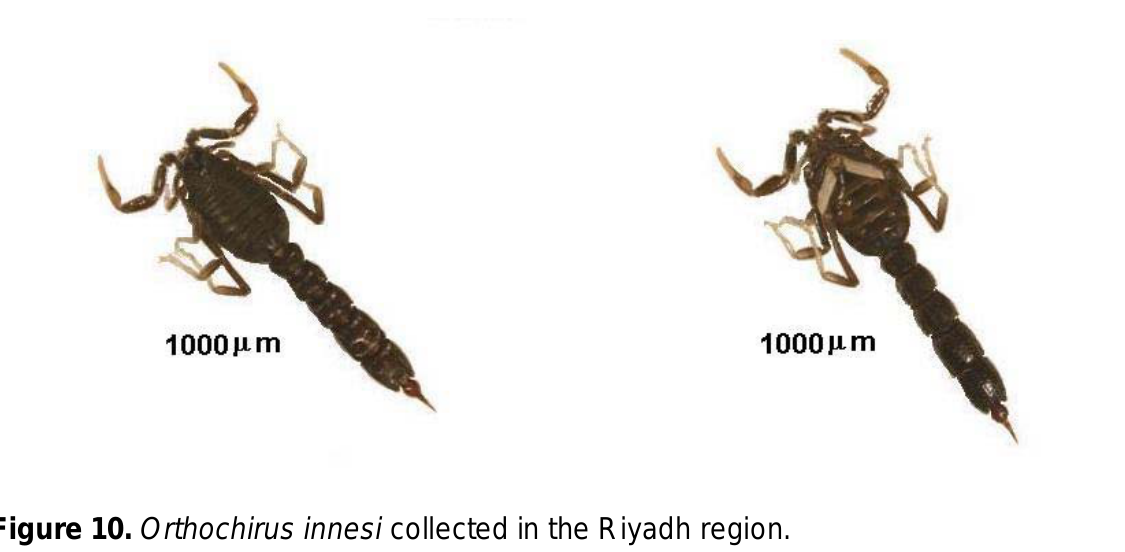
Figure 10. Orthochirus innesi collected in the Riyadh region.